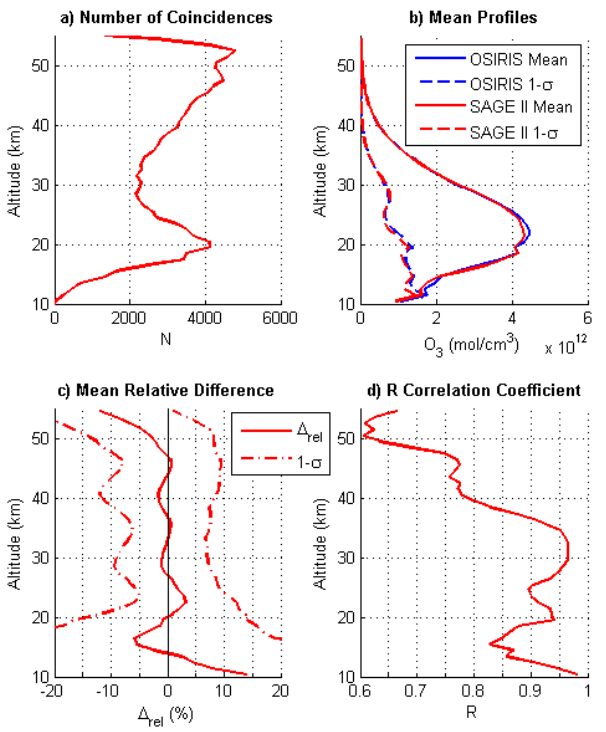
Fig. 5. As for Fig. 3 for dynamical coincidence criteria (see Table 1). Figure 5: As for Fig. 3 for dynamical coincidence criteria (see Table 1). 2